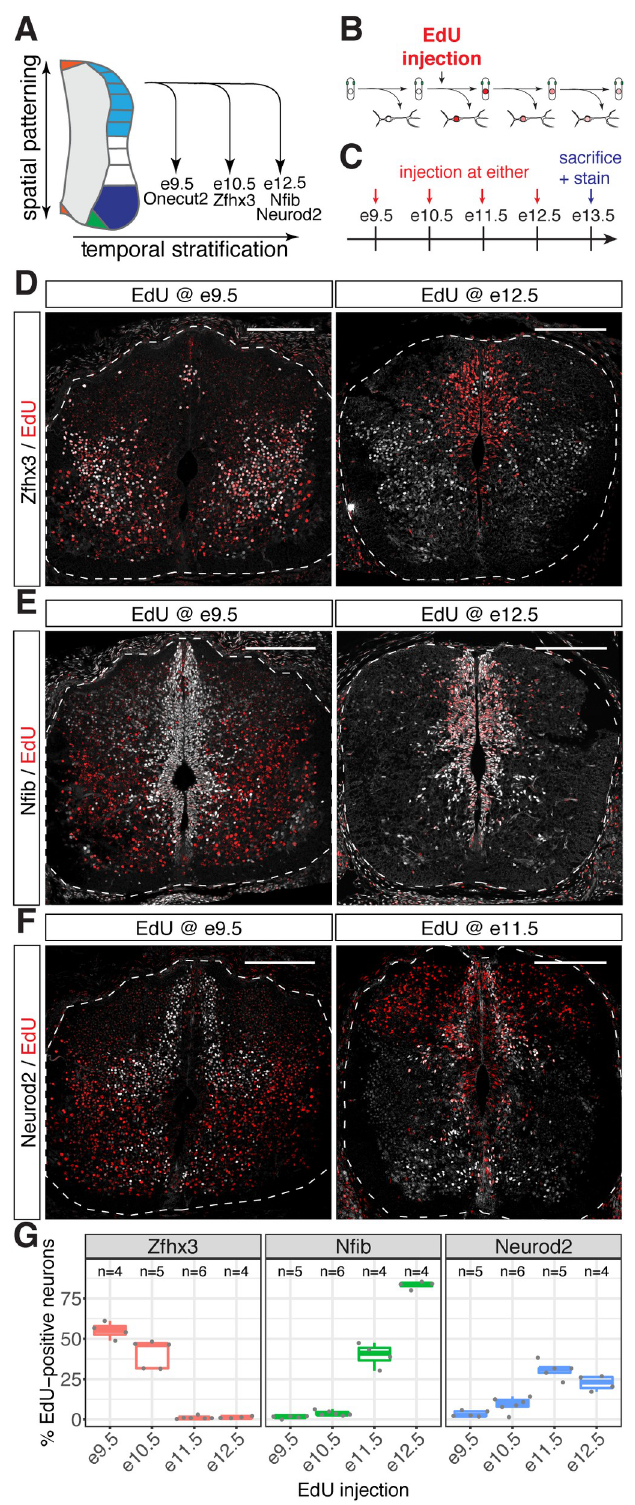
Fig 1. Distinct birthdates of neurons expressing different temporal TFs (see also S1 and S2 Figs). (A) Distinct cohorts of TFs are induced at different developmental stages in neurons from all dorsal–ventral domains in the spinal cord. (B) Scheme depicting EdU birthdating of neurons. (C) Dams were injected with EdU at e9.5, e10.5, e11.5,